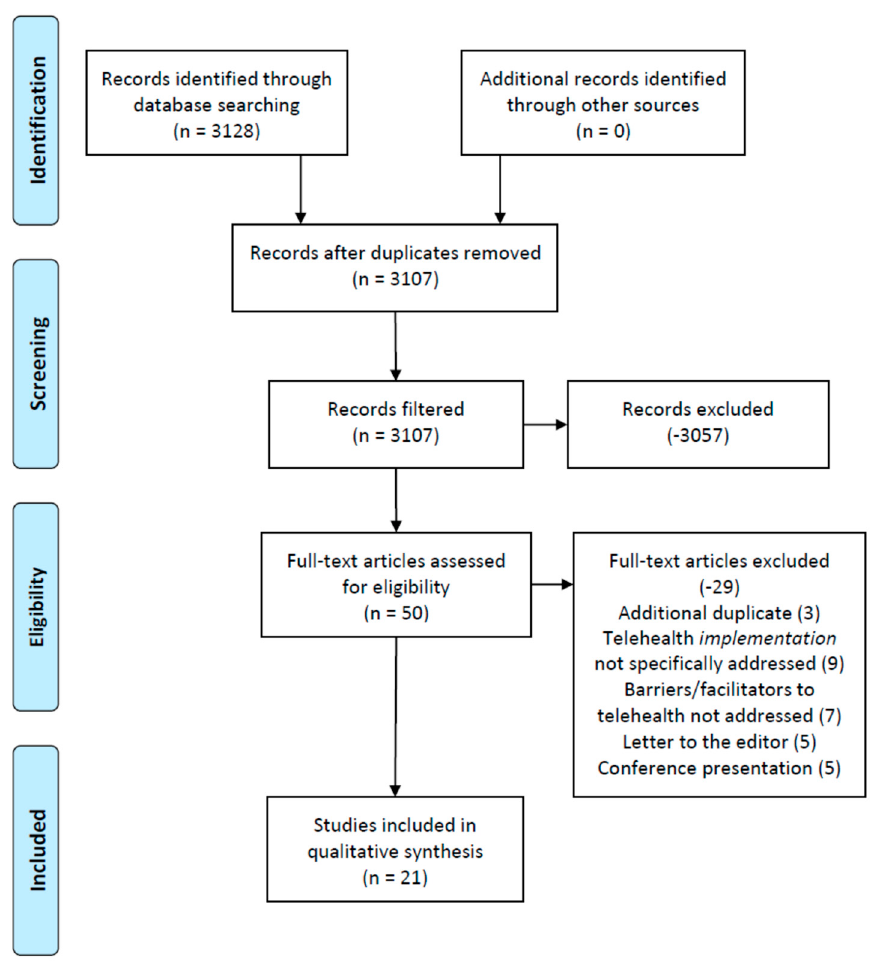
Figure 1. Preferred reporting items for rapid reviews and meta-analyses (PRISMA) figure that demonstrates the study selection process.